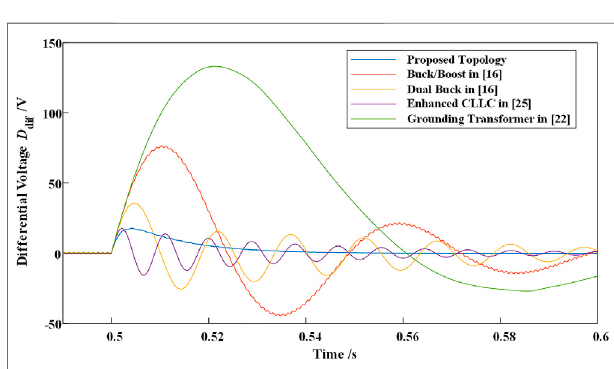
FIGURE 14 | Differential Voltage U dif with different LVDC balance